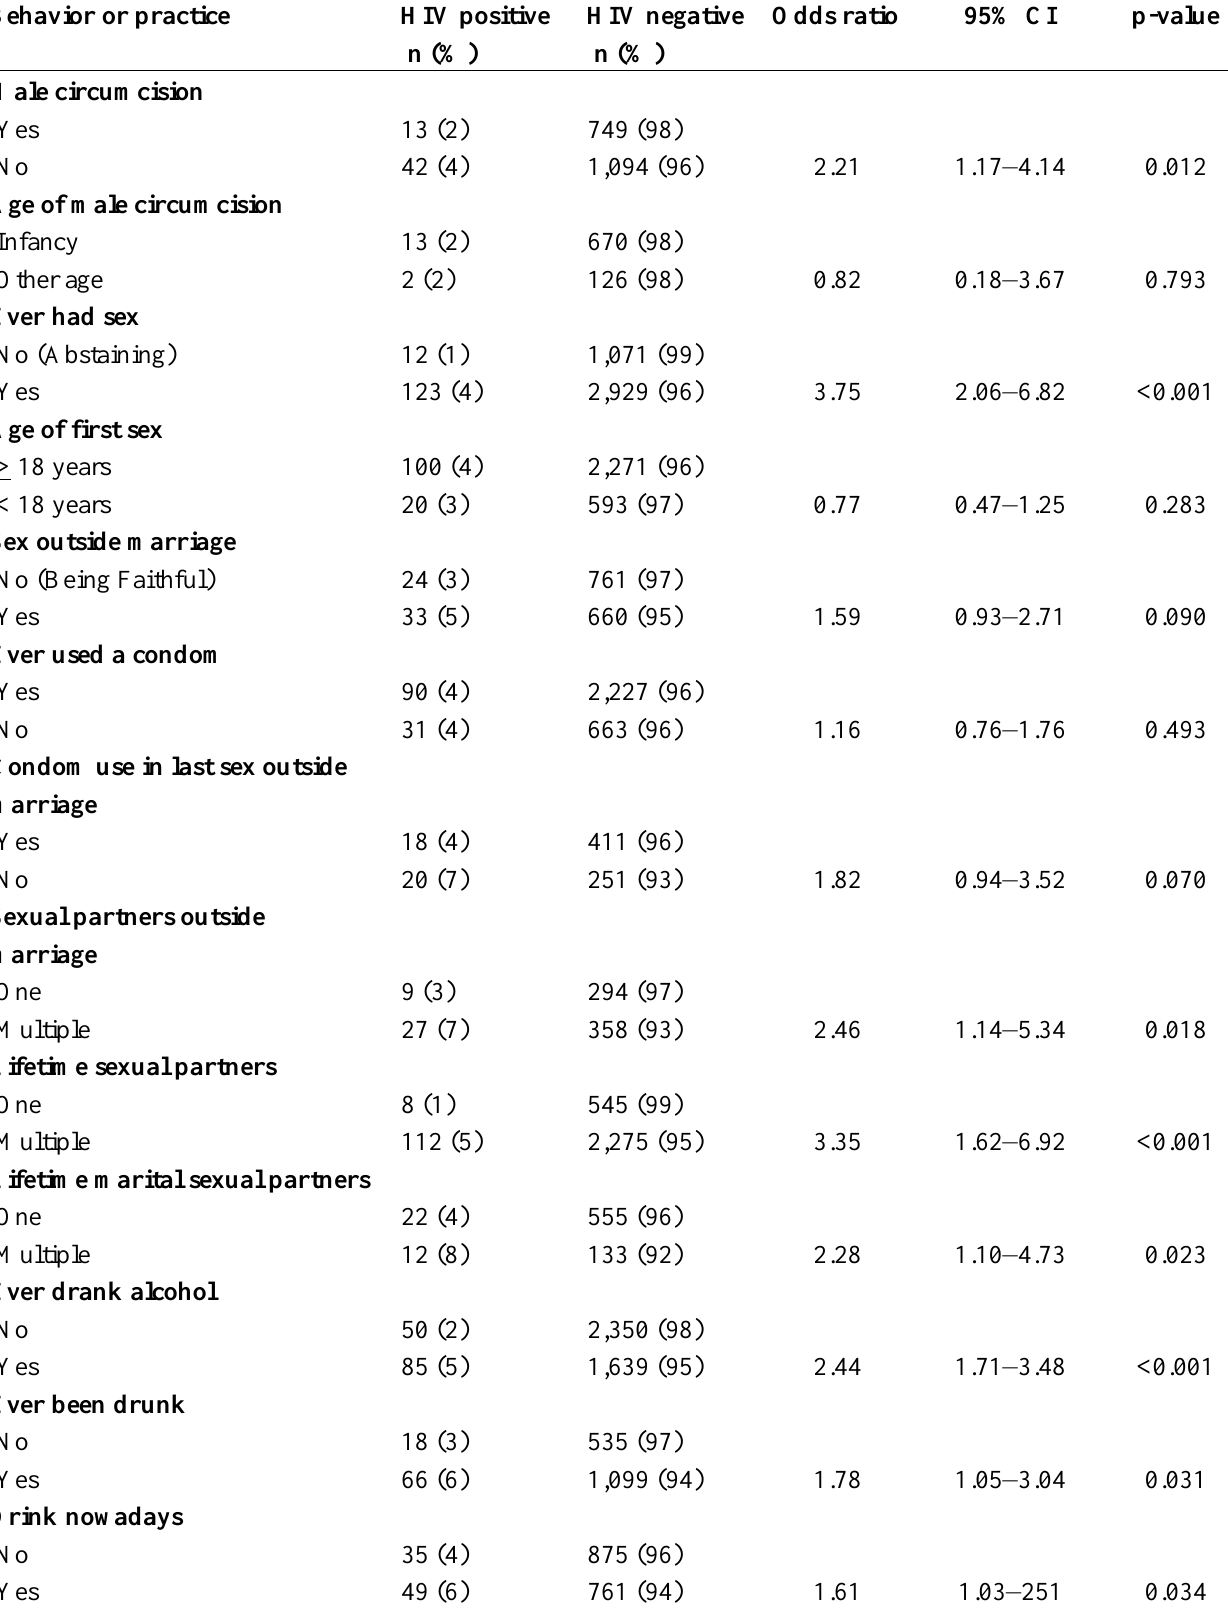
Table 1. Association between HIV-risk behaviors and HIV infections among Muslims and Christians